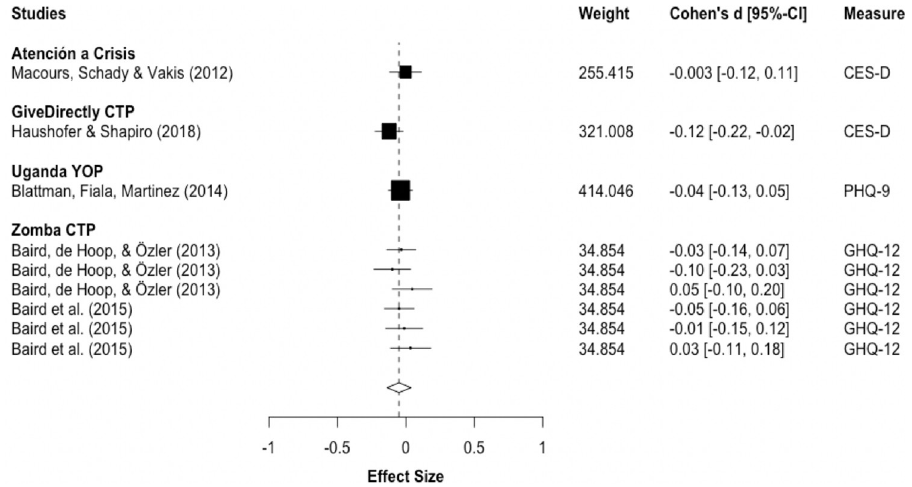
Fig 4. Depression and anxiety at follow-up. Notes: RVE correlated effects model with small-sample corrections. Robust standard errors adjusted at program-level. Outcomes are coded so that negative Cohen’s d-values indicate improvements. Diamond and dashed line display overall estimate of d pooled = -0.0508, width of diamond represents 95%-CI [-0.14, 0.04].